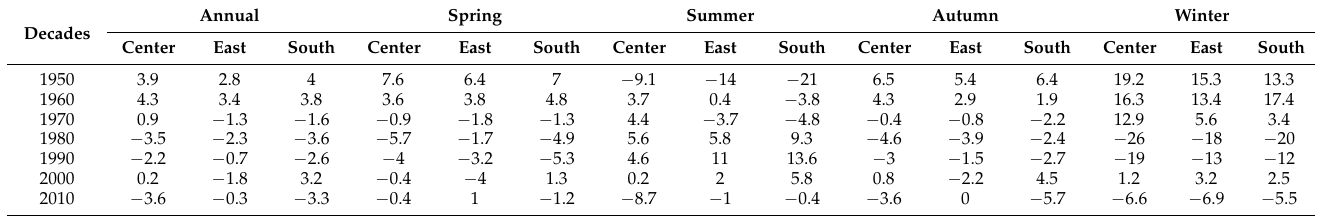
Table 4. Deviations (%) of the decadal annual and seasonal averages of rainfall compared to their interannual means for the southern regions of the country (Center, East, and South).